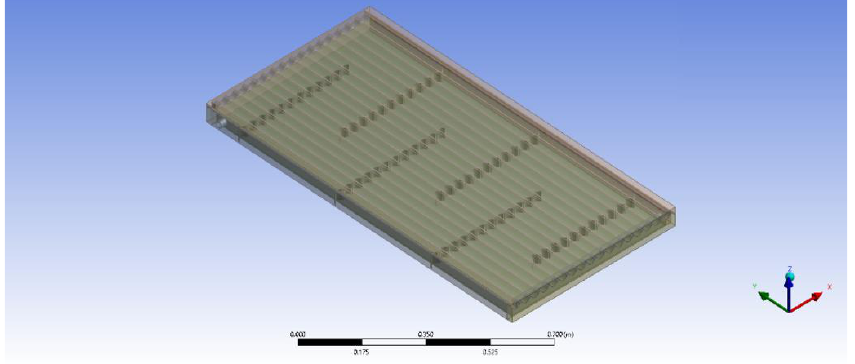
Figure 1. Geometric diagram of the solar air heater (SAH).